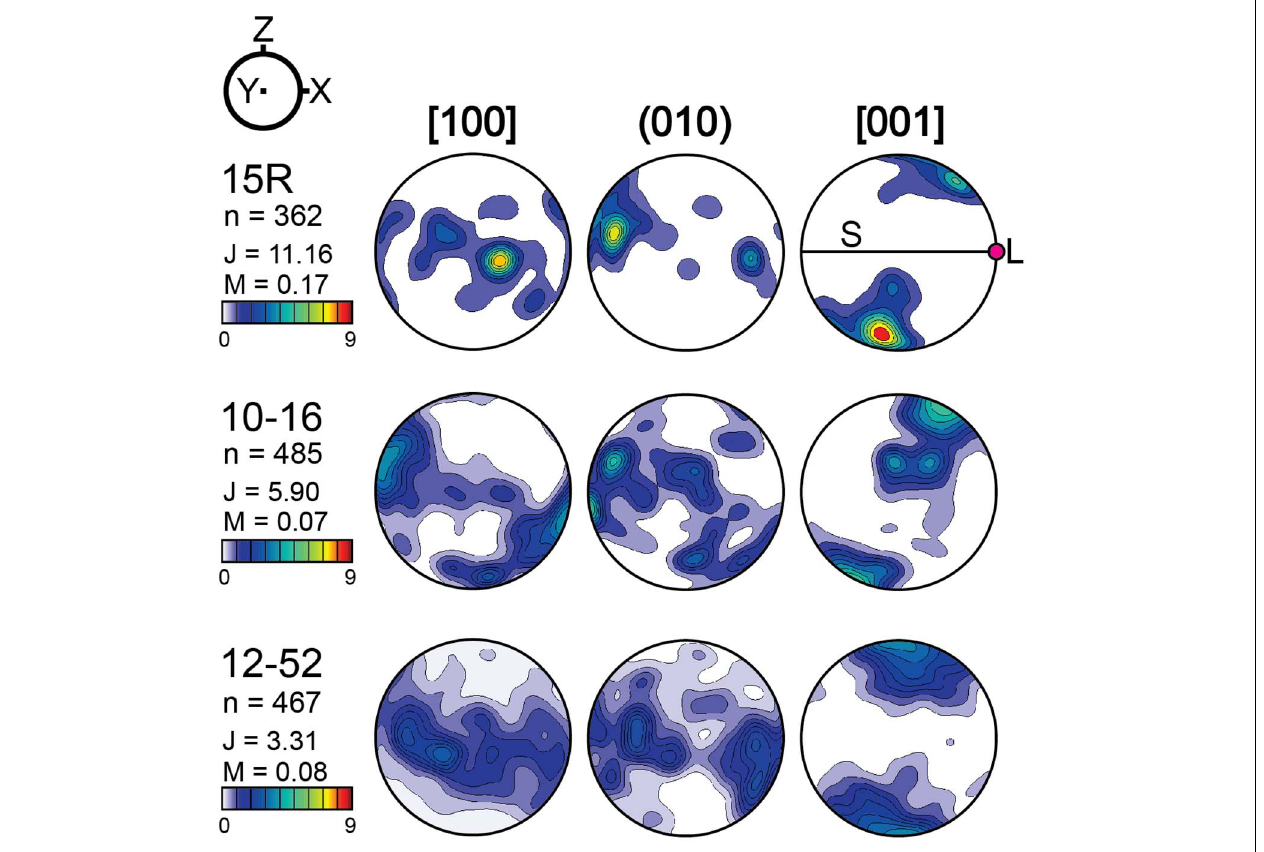
FIGURE 3 | Pole figures showing the LPO of chloritoid in the three UHP Makbal schist samples. Pole figures are presented in the lower hemisphere using an equal area projection. Pole figure density is shown with colorbar in units of multiples of a random distribution. Fabric strengths are also presented as J-index (J) and M-index (M). The X-direction is parallel to the lineation (L), Z-direction normal to the foliation (S), and the Y-direction orthogonal to the X- and Z-direction. To the left of the pole figures, n represents the number of the analyzed grains.